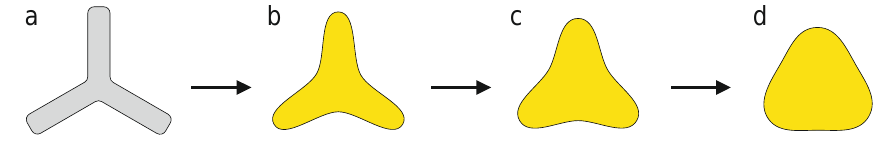
Figure 5. Typical die for trilobal cross-sections ( a ) and resulting trilobal filaments gaining in roundness due to increasing solidification time ( b–d ). By way of illustration, the polymer melt is represented in yellow.